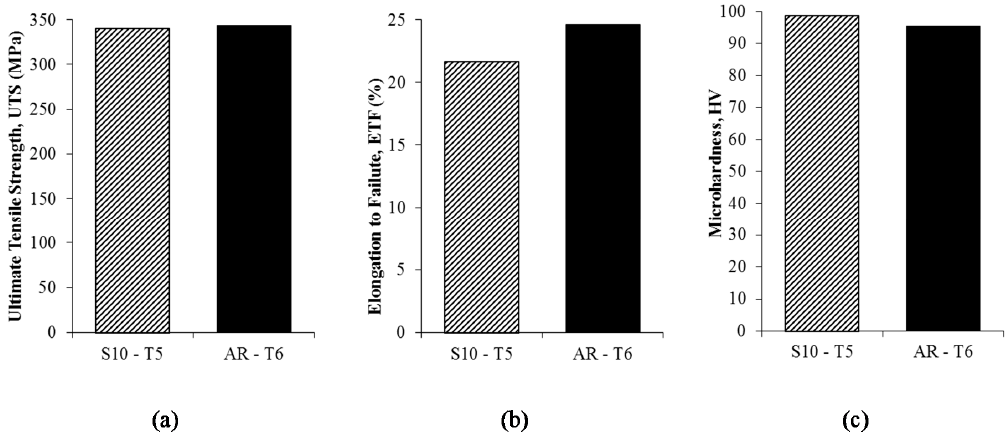
Figure 9. Results of heat treated recycled aluminium and as-received AA6061: ( a ) ultimate tensile strength; ( b ) elongation to failure; and ( c ) microhardness.